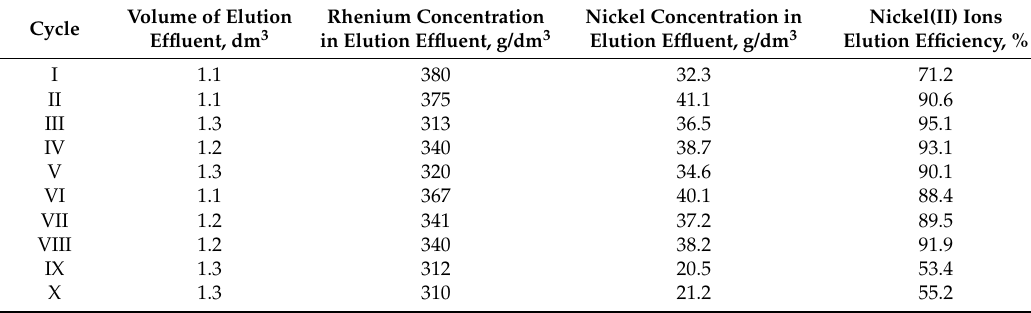
Table 3. Nickel(II) ions elution results—10 cycles before the